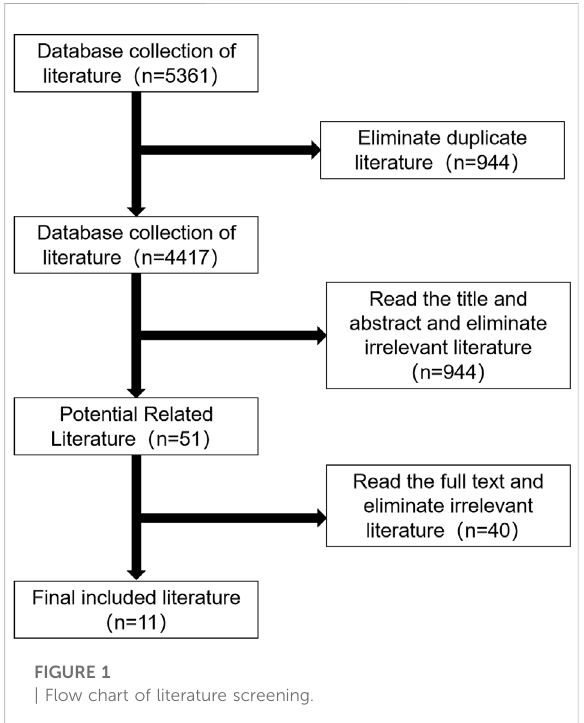
| Flow chart of literature